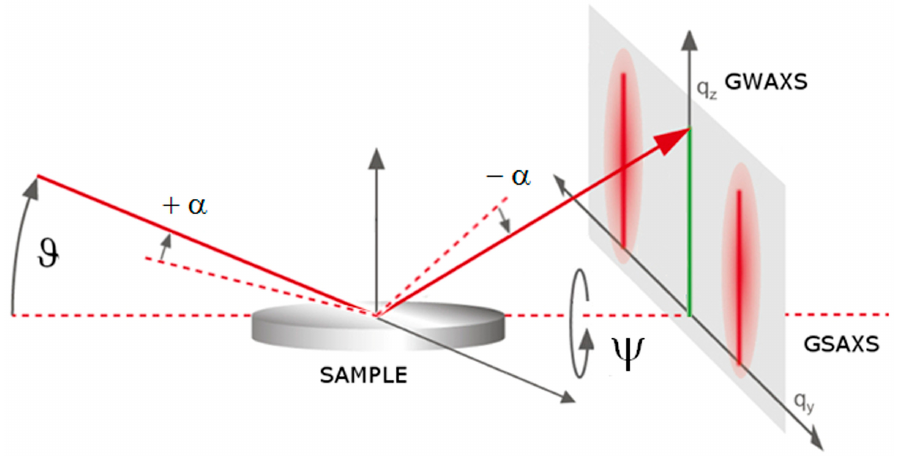
Figure 2. Schematic draft of energy dispersive GWAXS and GSAXS, where the X-ray scattering angle ( ϑ ), the in-plane α tilt, and out-of-plane Ψ tilt, as well as the relative q y and q z directions are shown. At first, a rocking curve (RC) analysis was performed upon the 10 MLs √ 3 × √ 3 Si film grown on reconstructed Si(111) √ 3–Ag, moving symmetrically the sample along the ± α directions, thus keeping the whole scattering-angle unchanged (see Figure 2), to minimize the Si(111) contribution along the